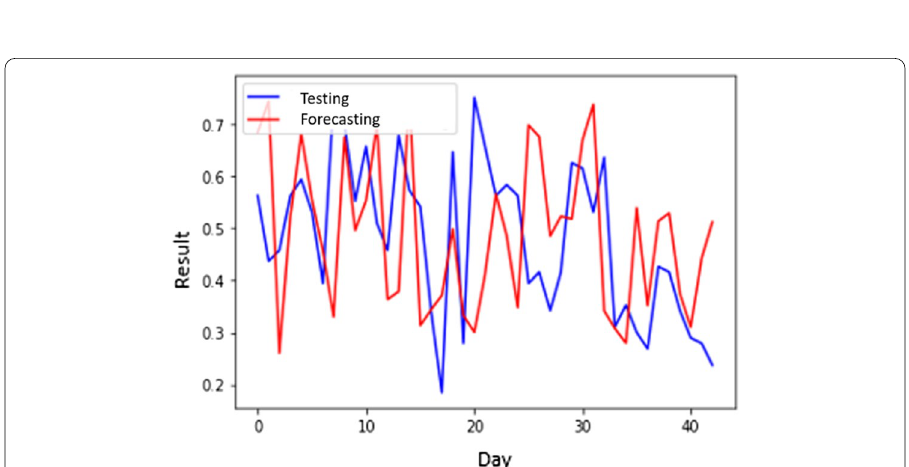
Fig. 8 The forecasting results of CNN scenario